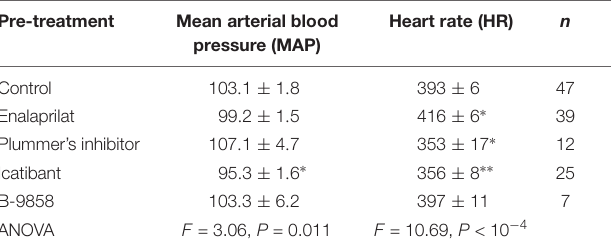
TABLE 2 | Basal cardiovascular parameters in anesthetized, pre-treated rats.